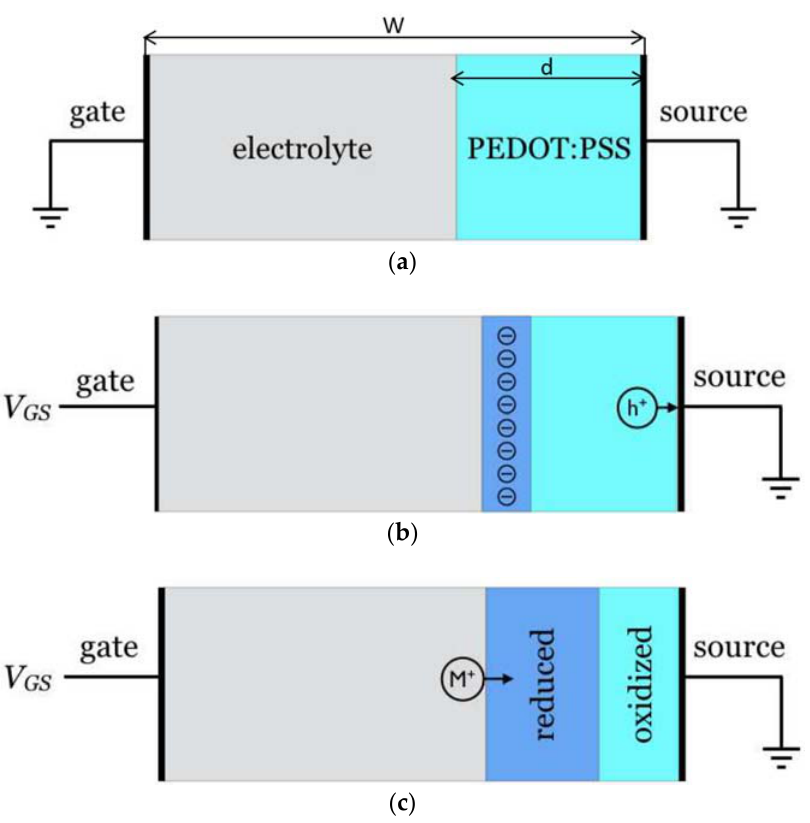
Figure 1. Structure of the OECT ( a ) at equilibrium (no voltage applied); ( b ) upon application of a gate-source voltage V GS , holes h + leave the polymer. Because of the high concentration of holes in the oxidized polymer, this leads to the formation of a thin space charge layer at the electrolyte–polymer interface; then ( c ) driven by the electric field in the space charge layer, M + cations penetrate from the electrolyte, thus warranting electrical neutrality in the polymer. As a result, the profile of the reduced layer is profoundly reshaped, and could ultimately occupy the whole thickness of the polymer.